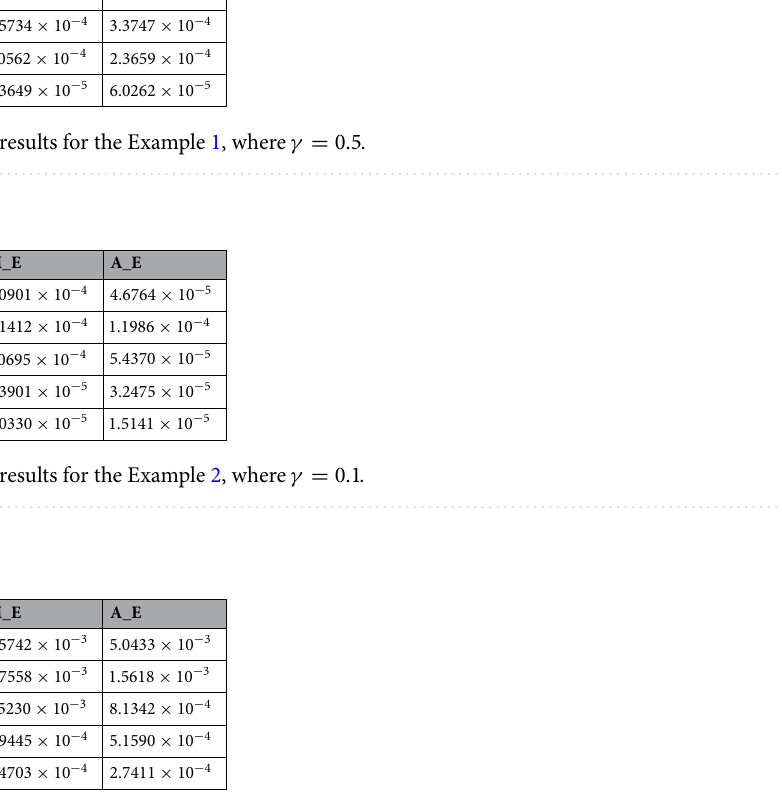
Table 4. Numerical results for the Example 2, where γ = 0.5